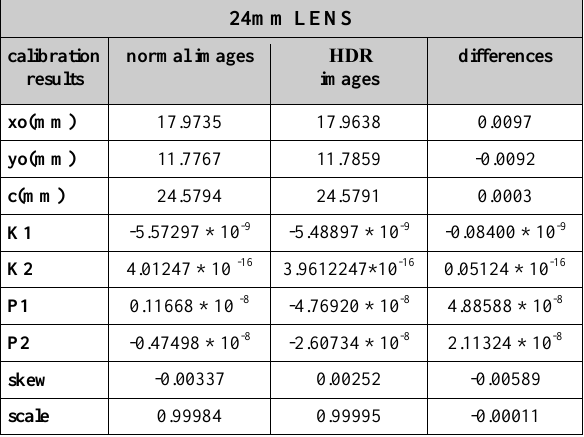
Table 1: Calibration results and comparison between normal and HDR images with 24mm focal length